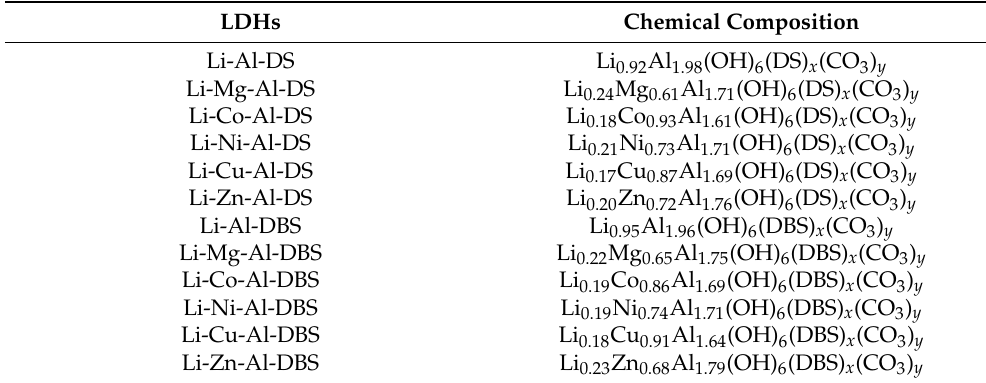
Table 3. The chemical composition of Li-Al-DS, Li-M-Al-DS, Li-Al-DBS, and Li-M-Al-DBS LDHs without considering interlayer water